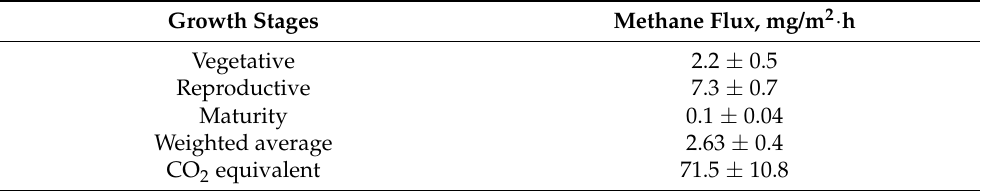
Table 3. Methane emission from ADT 45 rice field cultivated in ‘dry’ season at Koonimedu, Puducherry.